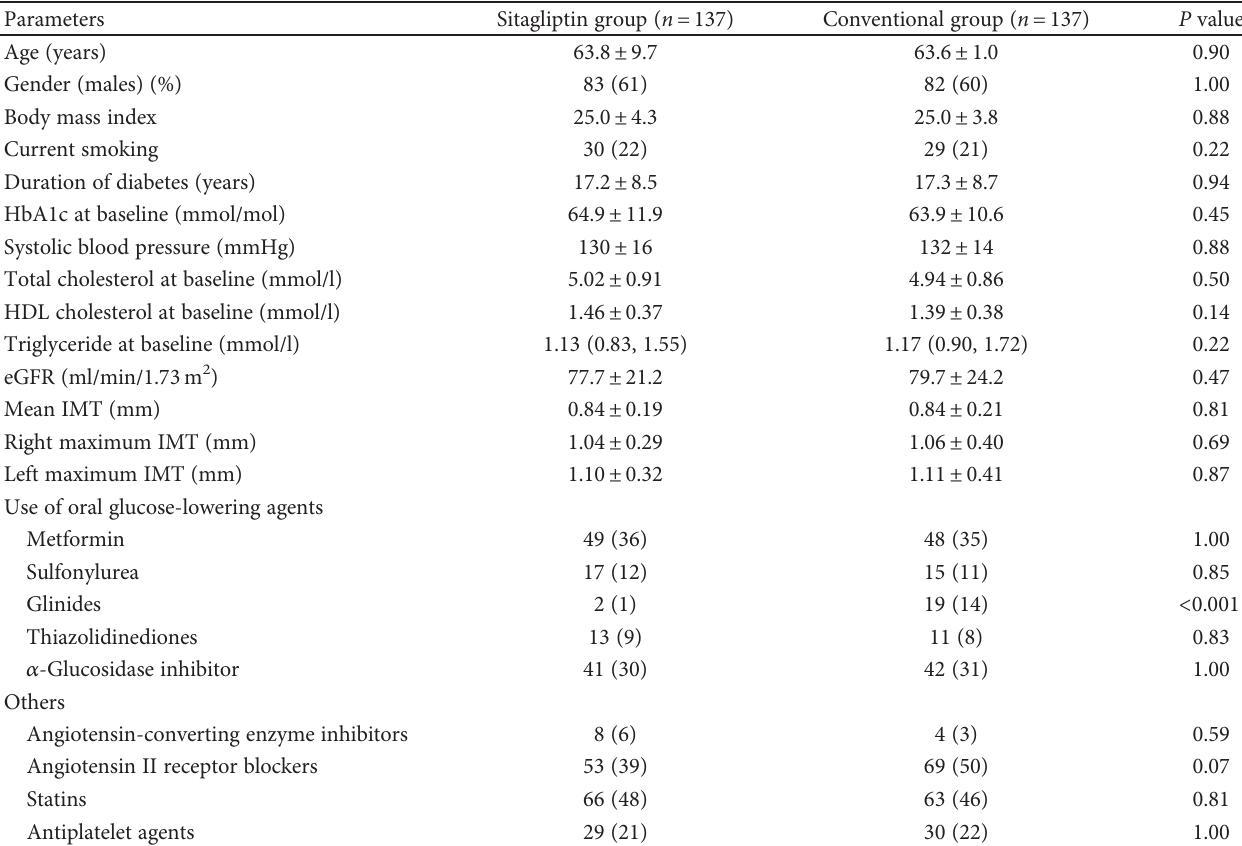
Table 1: Clinical characteristics of patients of the two groups.